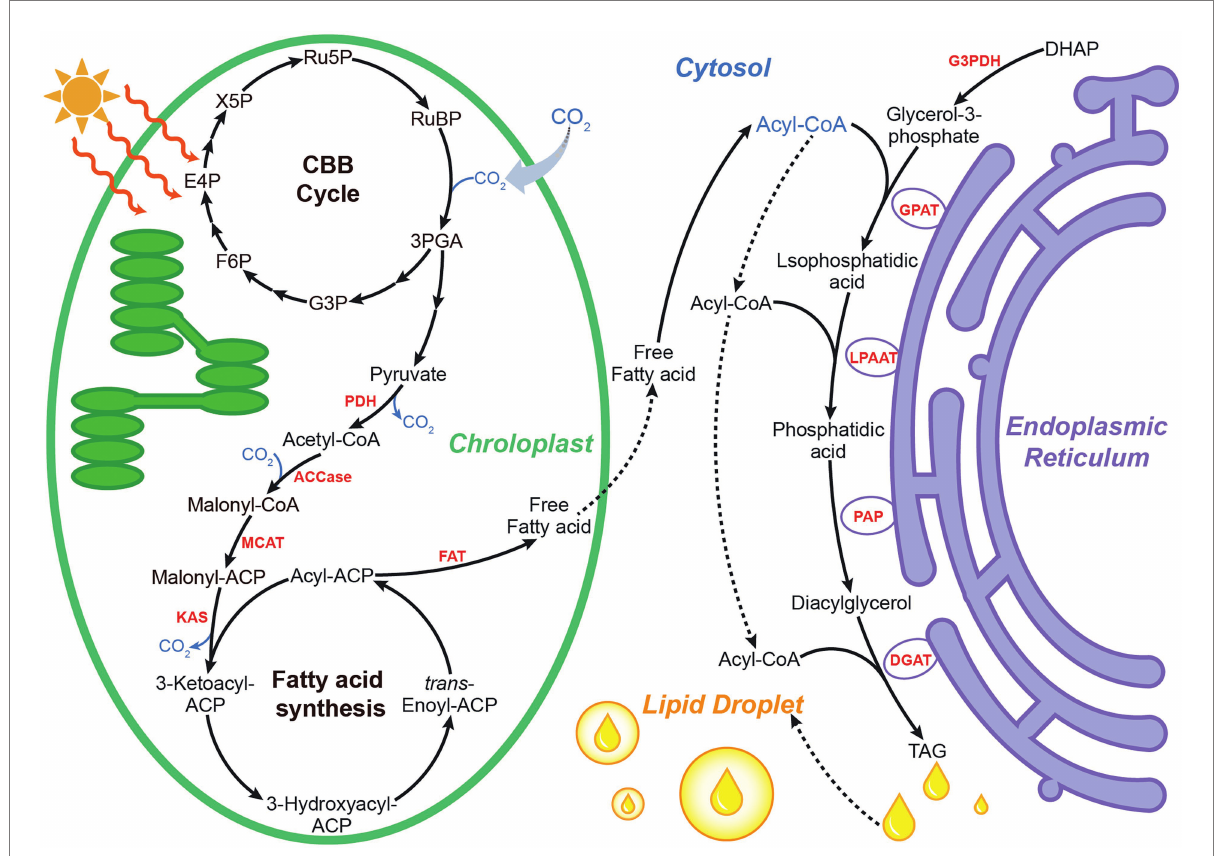
FIGURE 1 Schematic overview of metabolic pathways involved in lipid synthesis in microalgae. 3PGA, 3-phosphoglycerate; ACCase, acetyl-CoA carboxylase; DGAT, diacylglycerol acyltransferase; DHAP, dihydroxyacetone phosphate; E4P, erythrose-4-phosphate; F6P, fructose-6-phosphate; FAT, fatty acyl-ACP thioesterase; G3P, glyceraldehyde-3-phosphate; G3PDH, gycerol-3-phosphate dehydrogenase; GPAT, glycerol-3-phosphate acyltransferase; KAS, 3-ketoacyl-ACP synthase; LPAAT, lysophosphatidic acid acyltransferase; MCAT, malonyl-CoA: acyl carrier protein transacylase; PAP, phosphatidic acid phosphatase; PDH, pyruvate dehydrogenase complex; Ru5P, ribulose-5-phosphate; RuBP, ribulose-1,5- bisphosphate; TAG, triacylglycerols; X5P,